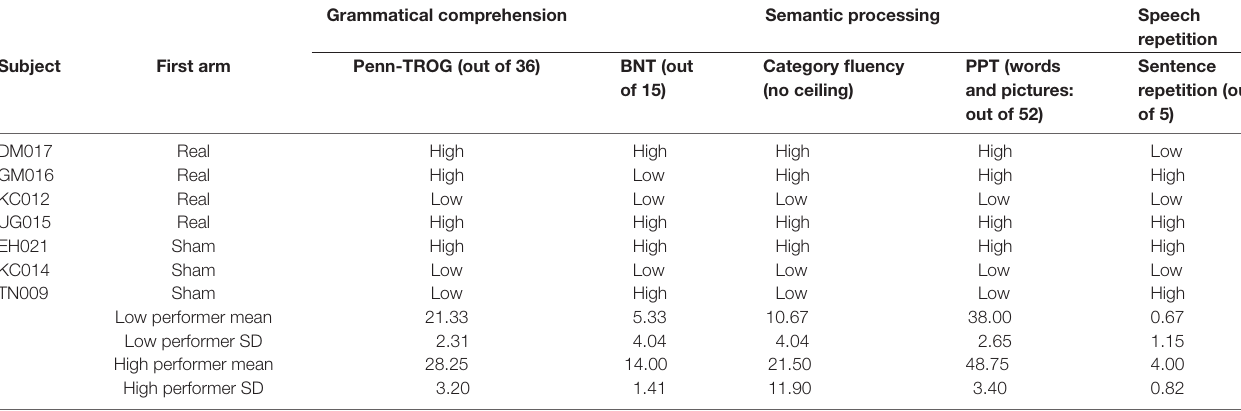
TABLE 2 | Spread of low and high performers across tasks at